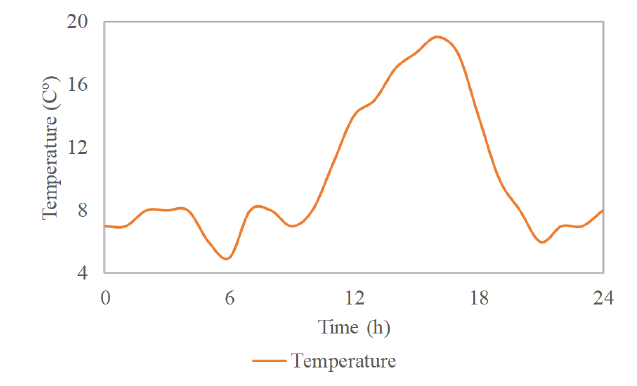
Figure 6. Profiles of outside temperature.